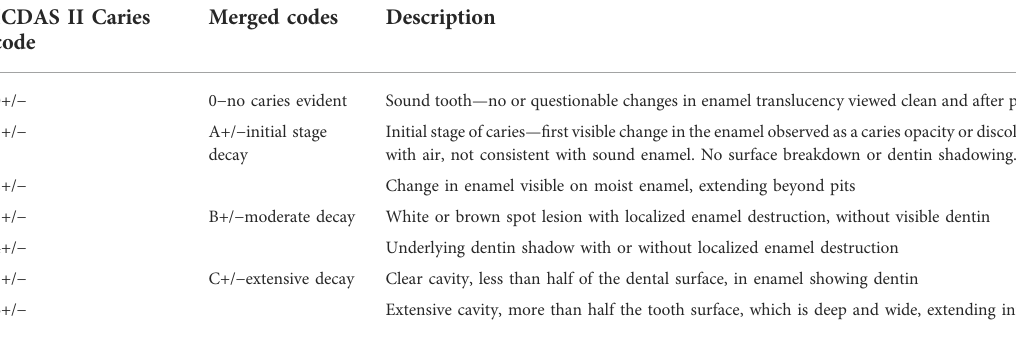
TABLE 2 ICDAS II Merged Caries Codes adapted from Pitts et al.